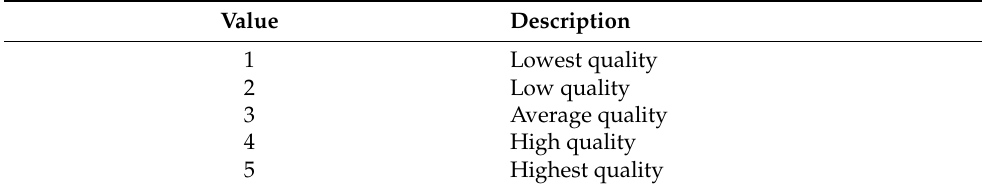
Table 2. The description of the used evaluation grades.